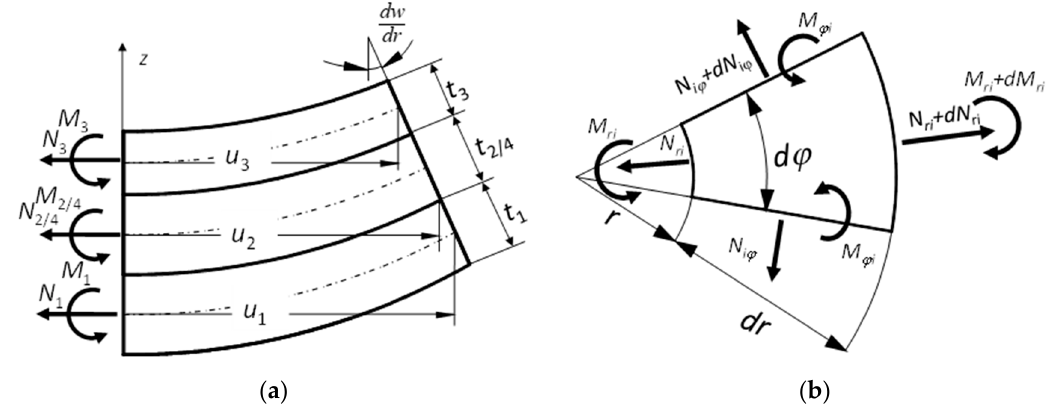
Figure 2. Fragment of the piezoelectric transducer structure: ( a ) deformed radial section, ( b ) system of forces acting on a small element of a transducer.